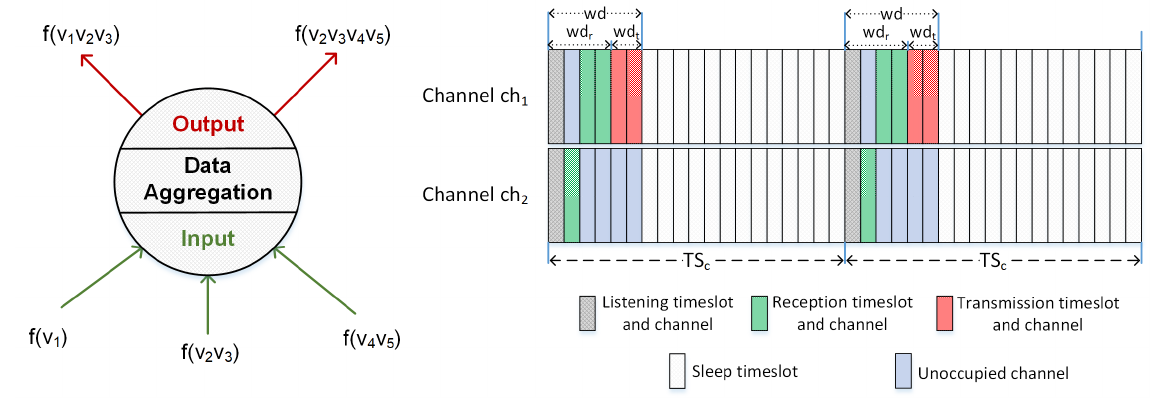
Figure 3. Example of many-to-many data aggregation scheduling on a